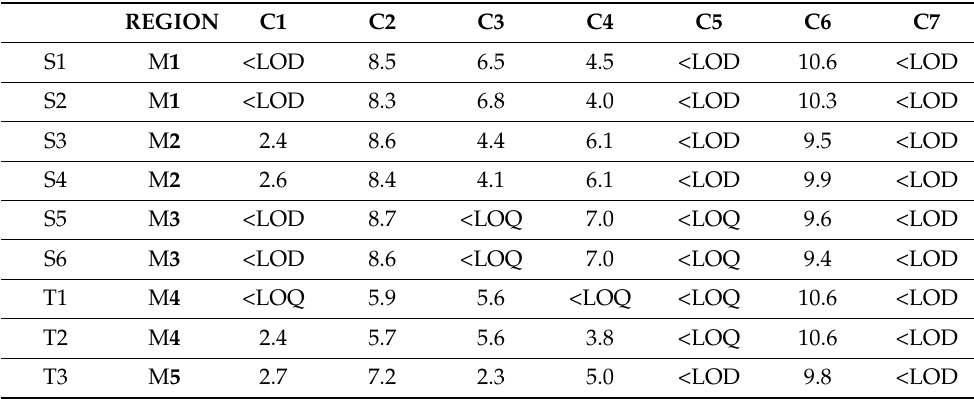
Figure 8. A chromatogram representing the separation of root sample P 1 using the validated method. Table 6. Quantitative analysis results for the different Mondia whitei samples (compound concentra- tion in solid samples (mg/kg) and in syrup samples